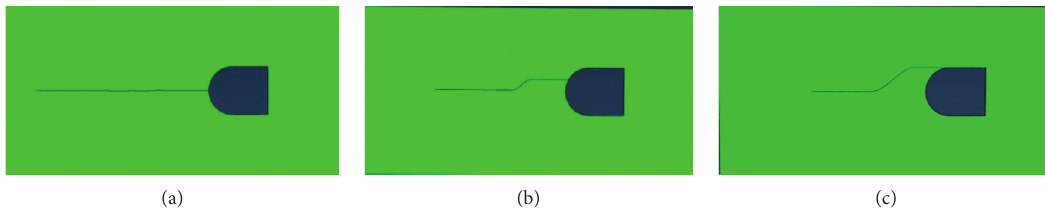
Figure 20: Crack growth trajectories under different locations of prefabricated cracks. (a) a � 0mm. (b) a � 5mm. (c) a � 10mm. X -direction displacement of crack tip 01020304050